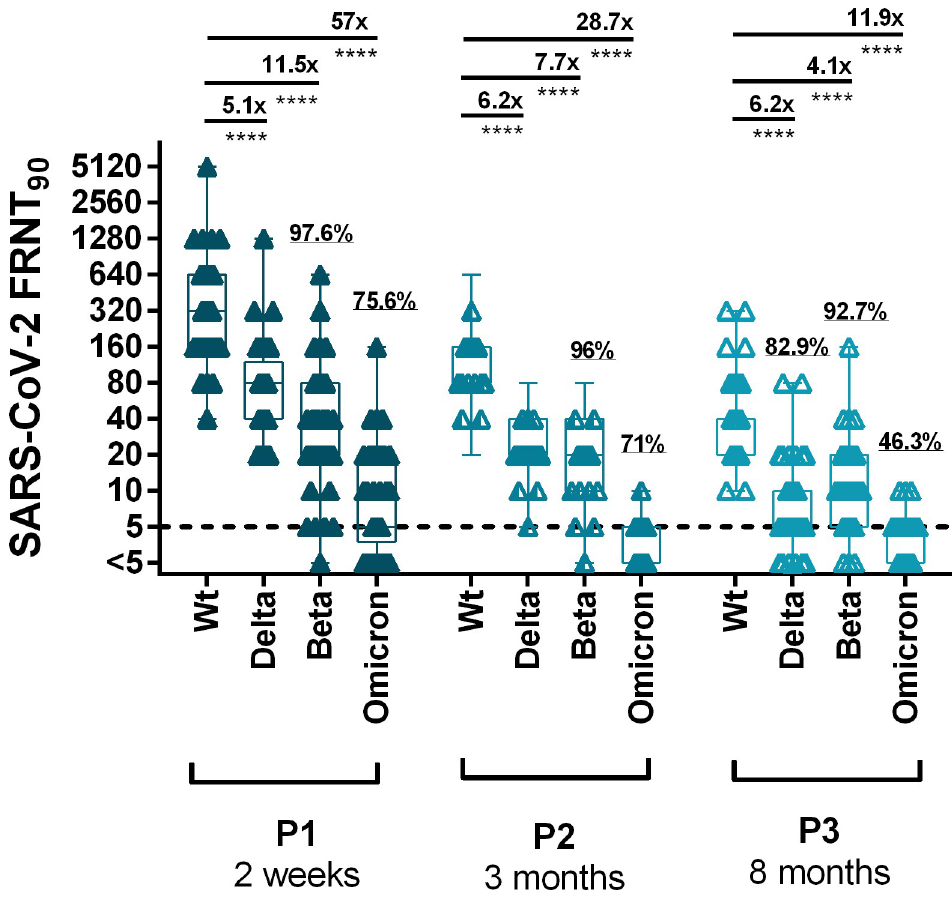
Fig 5. BNT162b2- and infection induced reciprocal SARS-CoV-2 nAb titers on wildtype strain wt-BavPat1 and VOC strains Delta, Beta and Omicron at timepoint P1 to timepoint P3. The dotted line indicates the limit-of- detection at a titer of 1:5. FRNT90: Focus reduction neutralization titer at 90% virus inhibition; results plotted as reciprocal values. Proportion of individuals with remaining nAbs in percent. Mean neutralizing titer reductions of SARS-CoV-2 wt to VOC-nAb are depicted above the continuous lines � = p < 0.05, �� = p < 0.01, ��� = p < 0.001, ���� = p < 0.0001, ns = not